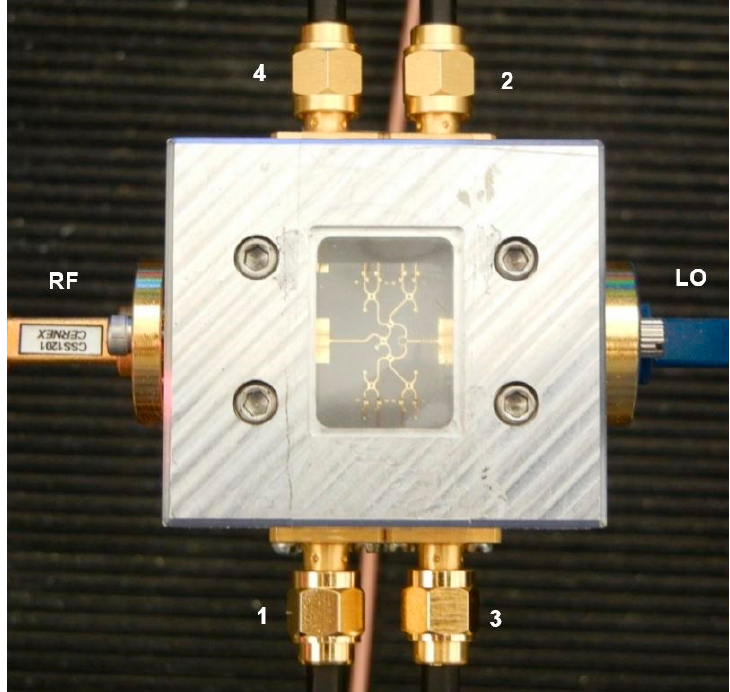
Figure 14. V-band multi-port in aluminum fixture with standard WR-12 flange and SMA connectors.